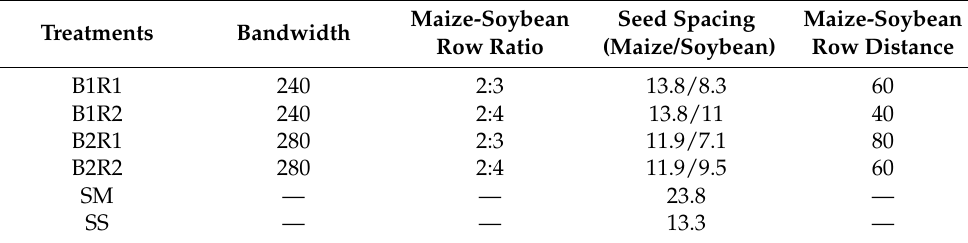
2.8 m, two rows maize with four rows soybean. SM—sole maize, SS—sole